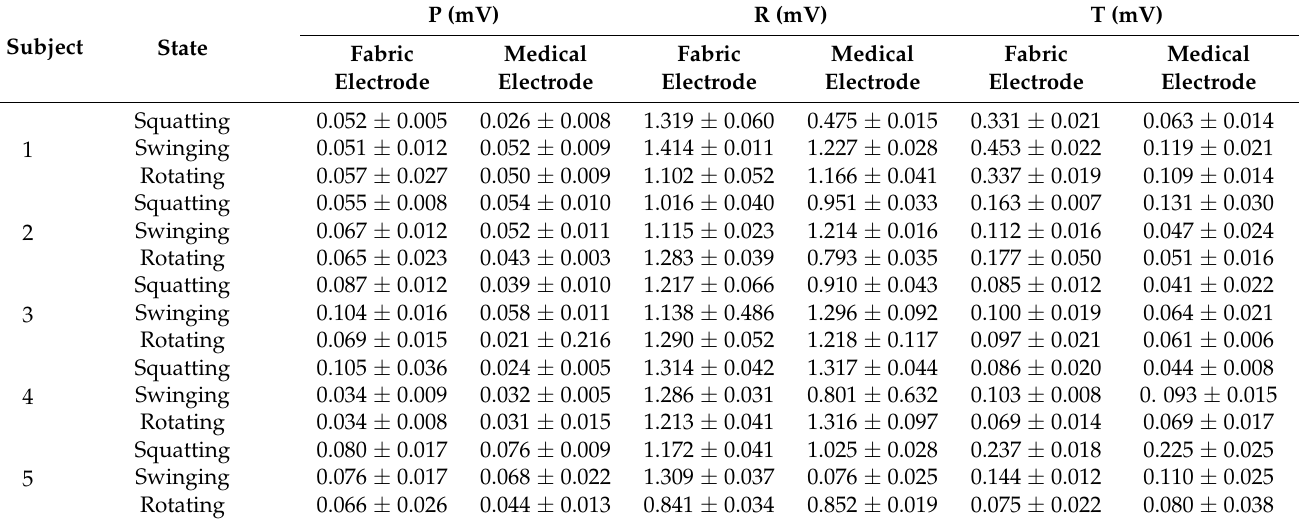
Table 3. Comparison of amplitudes for P, R, and T characteristic